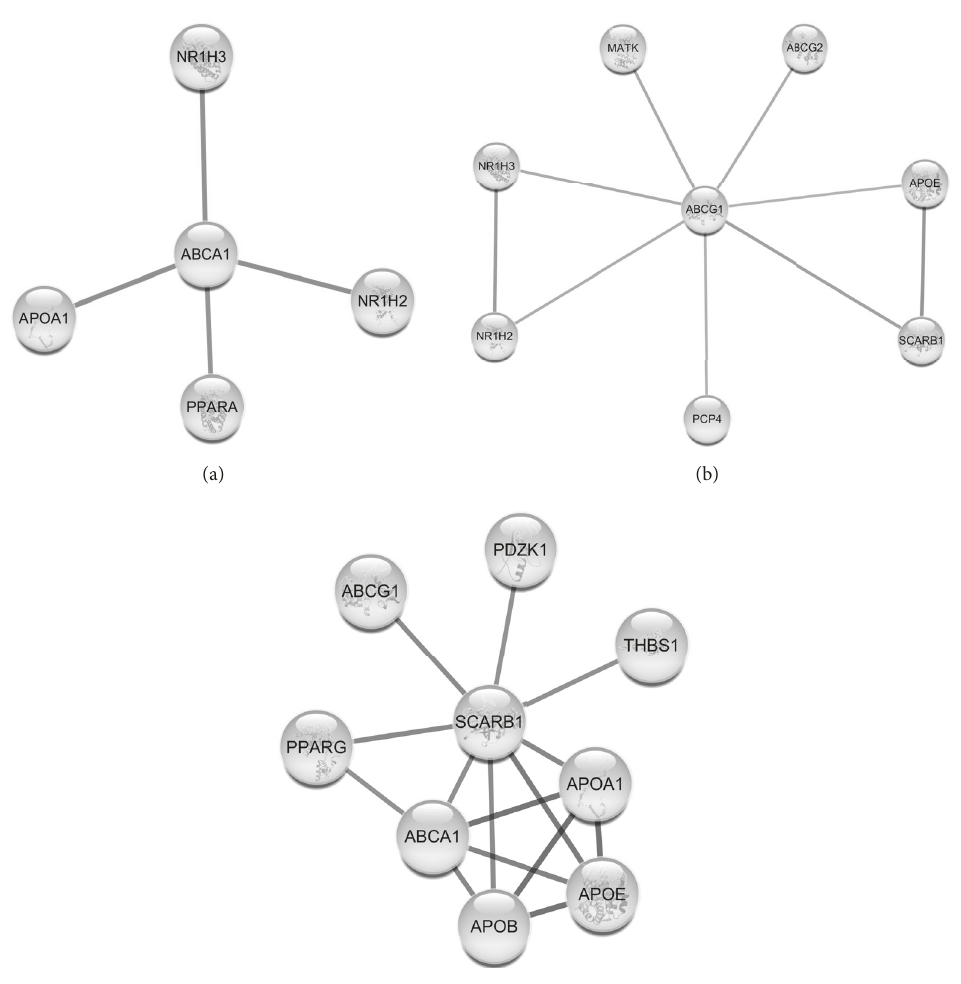
Figure 2: Protein-protein interactions involved in cholesterol efflux by cholesterol transporters. Data for human ABCA1 (a), ABCG1 (b), and SR-B1 (SCARB1) (c) molecules were imported from STRING database with Cytoscape STRING plugin. Confidence cutoff for interactions was chosen as 0.95, 0.7, and 0.8, respectively. (a) apoA-I is the major protein component of HDL; PPARA is a nuclear receptor, transcription factor, key regulator of lipid metabolism; NR1H2 is an oxysterols receptor LXR-beta–nuclear receptor that regulates cholesterol